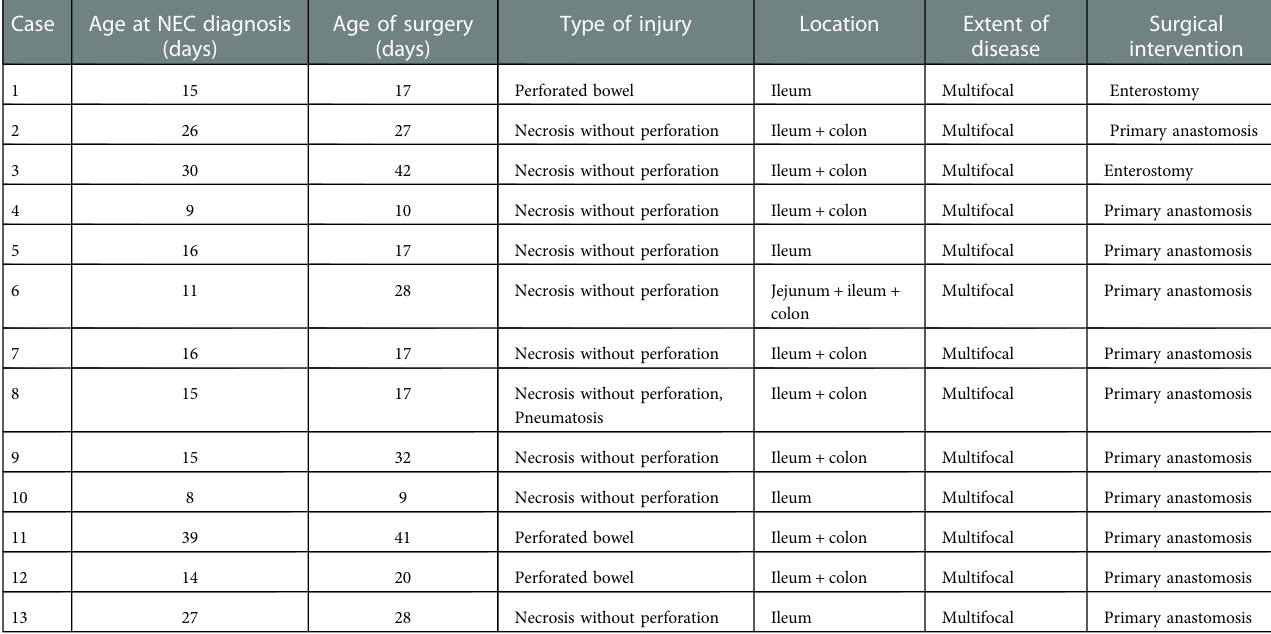
NEC, necrotizing enterocolitis.